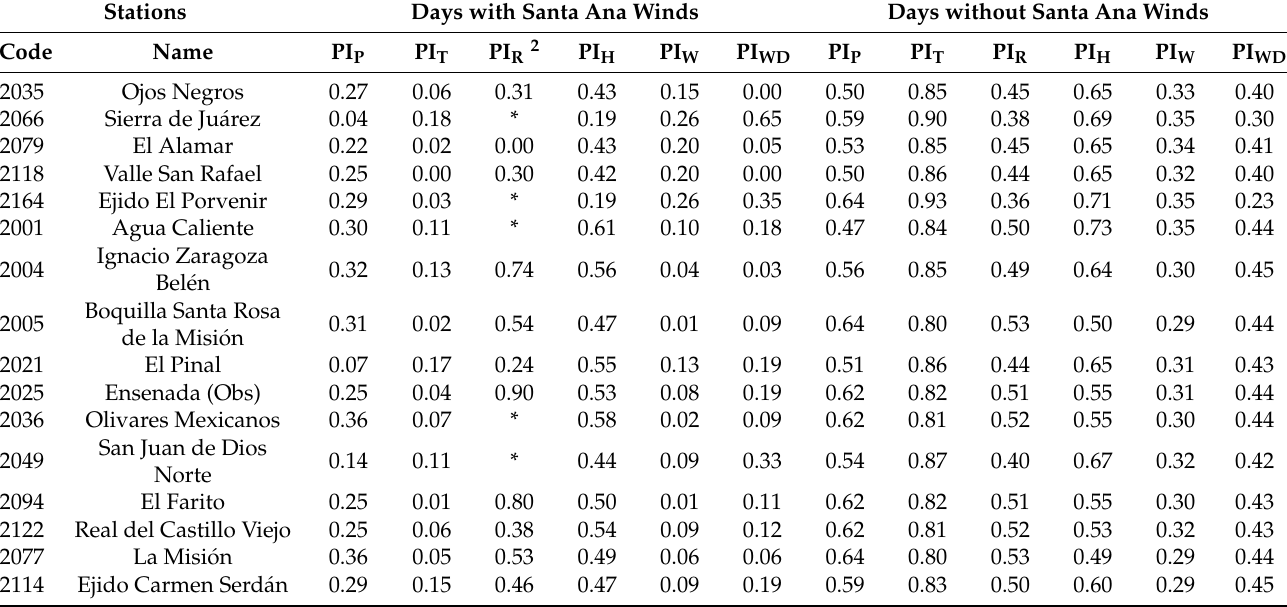
Table 4. Predictability indices of pressure, temperature, precipitation, relative humidity, wind speed, and wind direction for days with and without Santa Ana